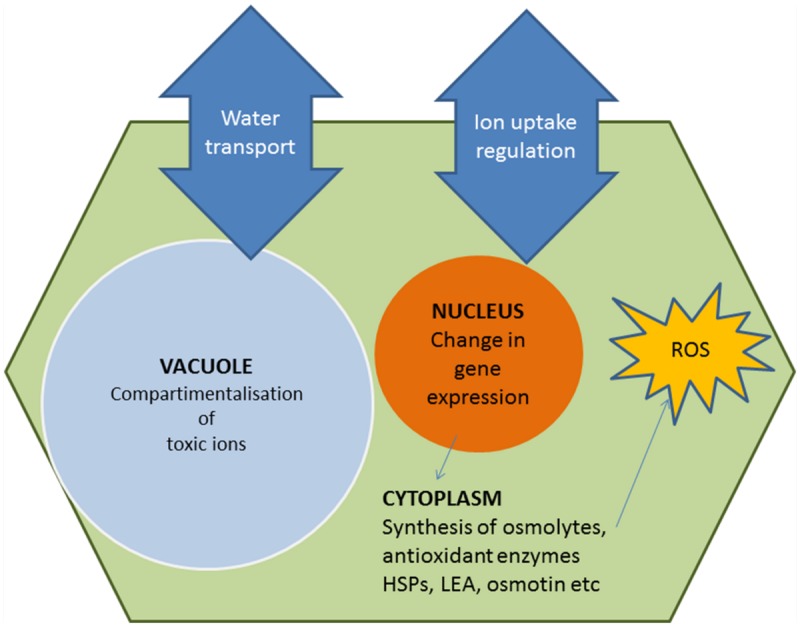
Diagram of basic and general stress responses caused by high soil salinity or drought. Under stress, plant cells try to counteract cellular dehydration through ion homeostasis and osmotic balance (Zhu, 2001; Munns and Tester, 2008; Kronzucker and Britto, 2011). Osmolytes not only contribute to osmotic adjustment, but also play ‘osmoprotectant’ roles (Ashraf and Foolad, 2007; Chen and Murata, 2008; Flowers and Colmer, 2008; Szabados and Savouré, 2010). They act as low-molecular-weight chaperons, directly stabilizing macromolecular structures and have additional functions in the mechanisms of response to stress, as ‘reactive oxygen species’ (ROS) scavengers, signal transduction elements or molecules for the storage of C and/or N and energy to be used during recovery from stress. The diagram has been elaborated by the authors.